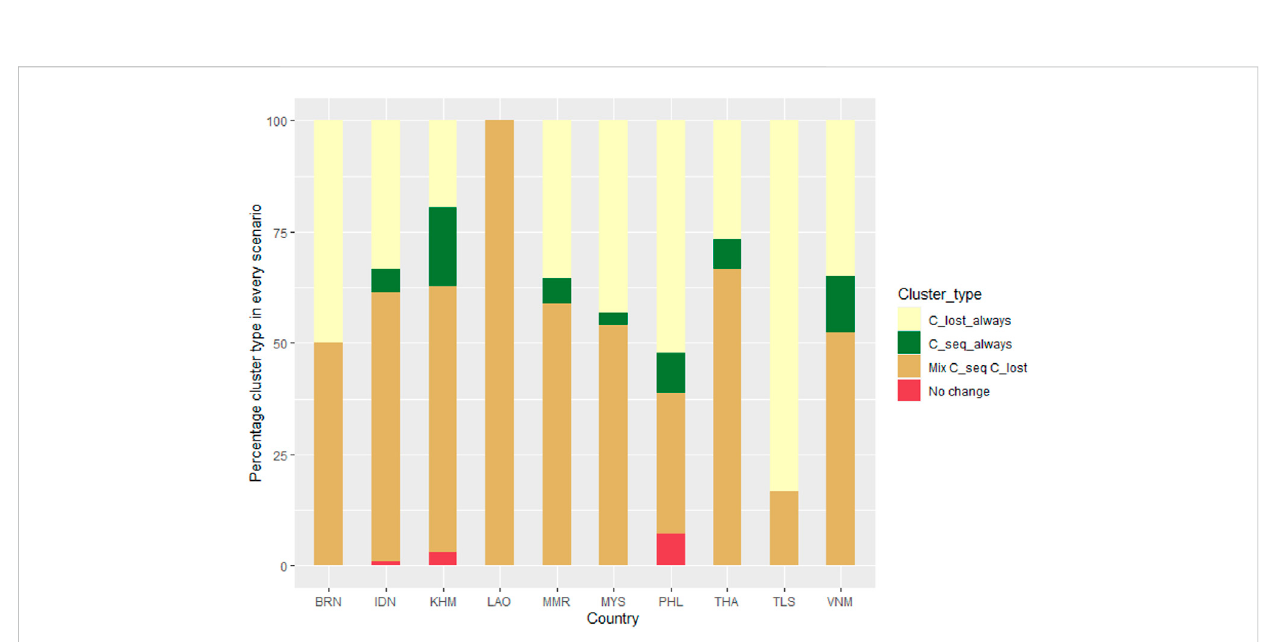
Distribution of urban clusters which are either sequestering carbon or losing carbon in every scenario country